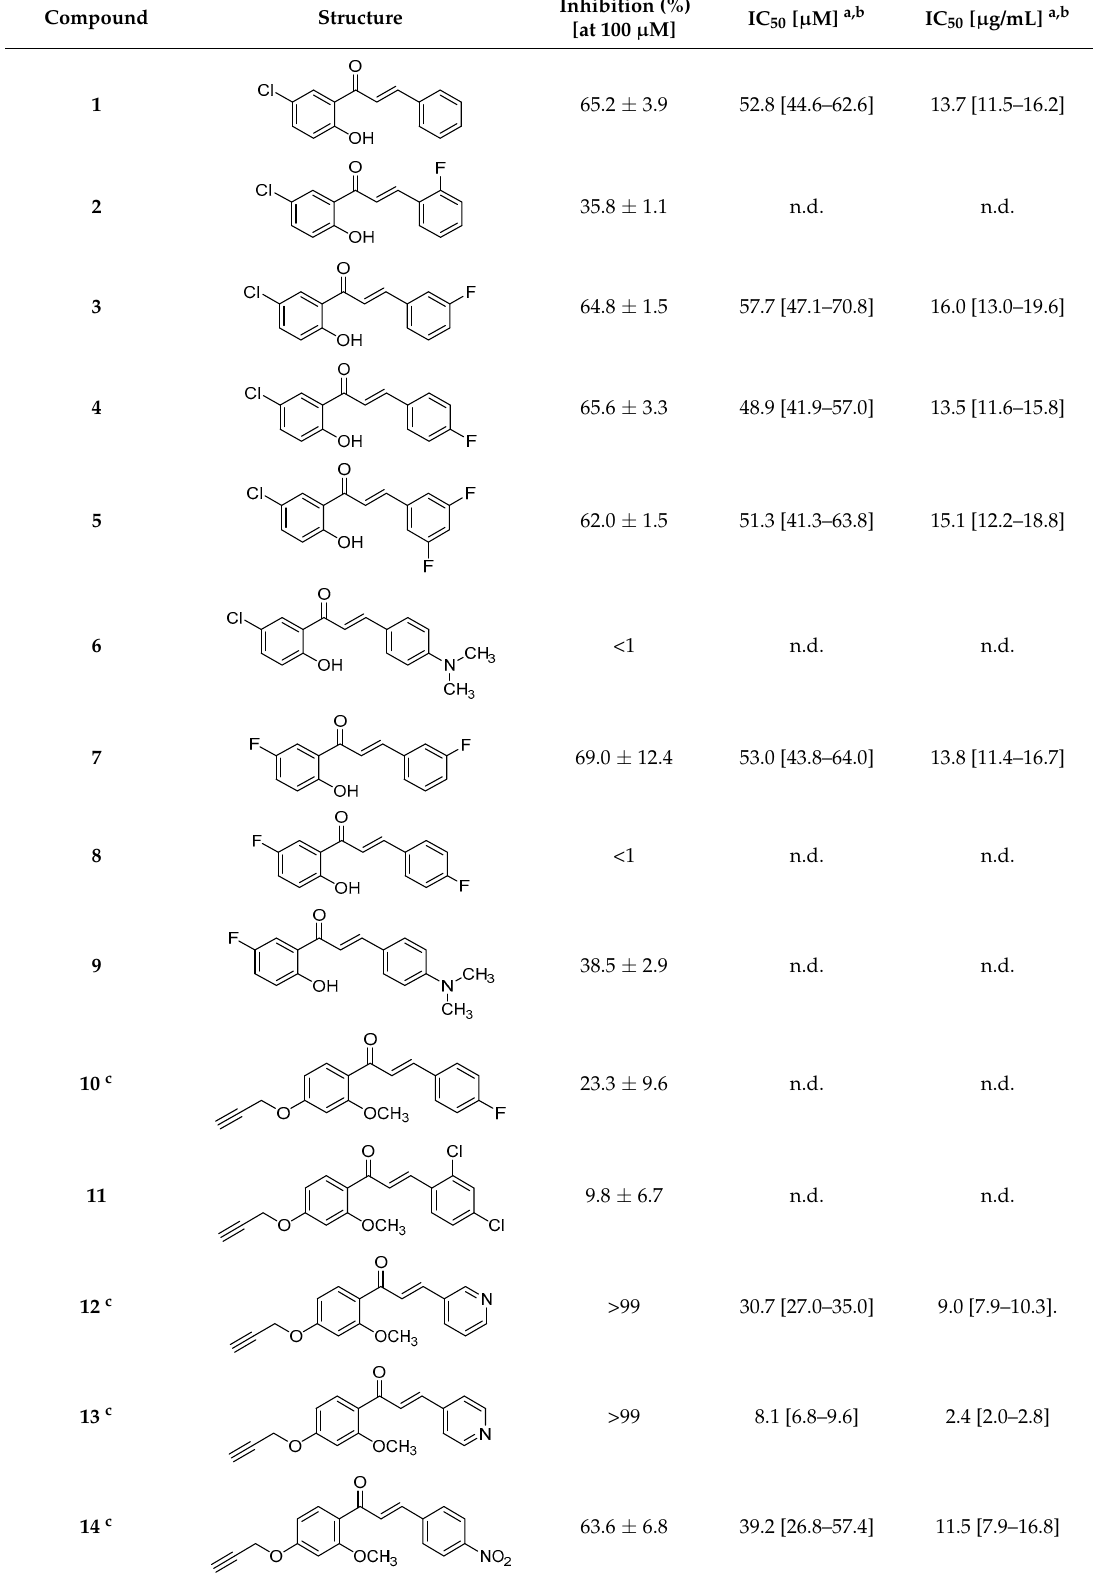
Table 1. Antifungal effect of chalcone-based analogues 1–40 against C. albicans control strain. Compound